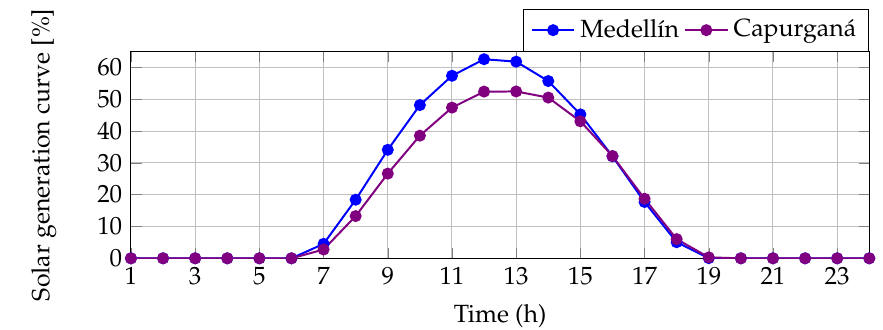
Figure 5. Expected average generation curve for Medellín and Capurganá, Colombia.